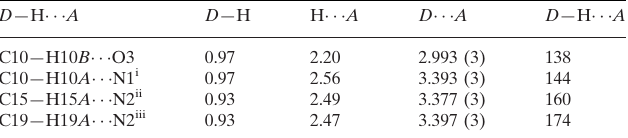
Hydrogen-bond geometry (A˚ , (cid:3)